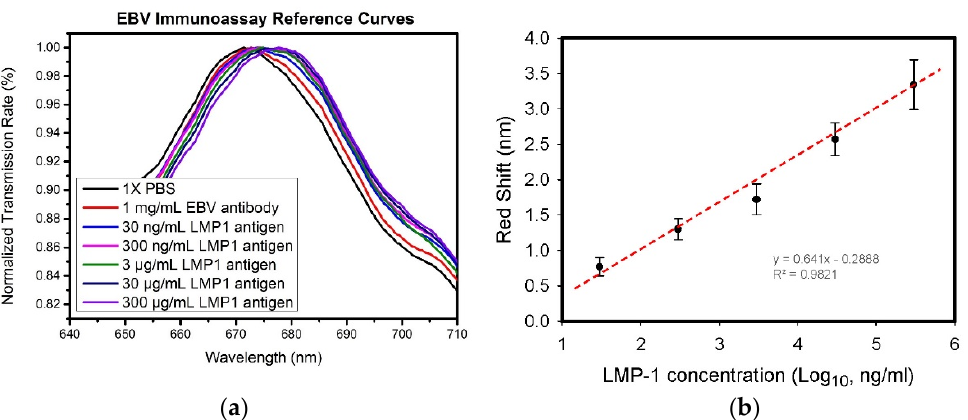
Figure 5. ( a ) Observation of resonant spectrum shifting when antigen and antibody were sequentially conjugated onto the nanoslit surface. ( b ) Analytical results of resonant spectra when the sensing chip was immersed in various concentrations of sample solutions. (Black dots and lines are averaged peak values and standard deviations of resonances when measuring various concentrations of LMP 1 antigen in three times, and red dot line is linear regression results of these averaged peak values )